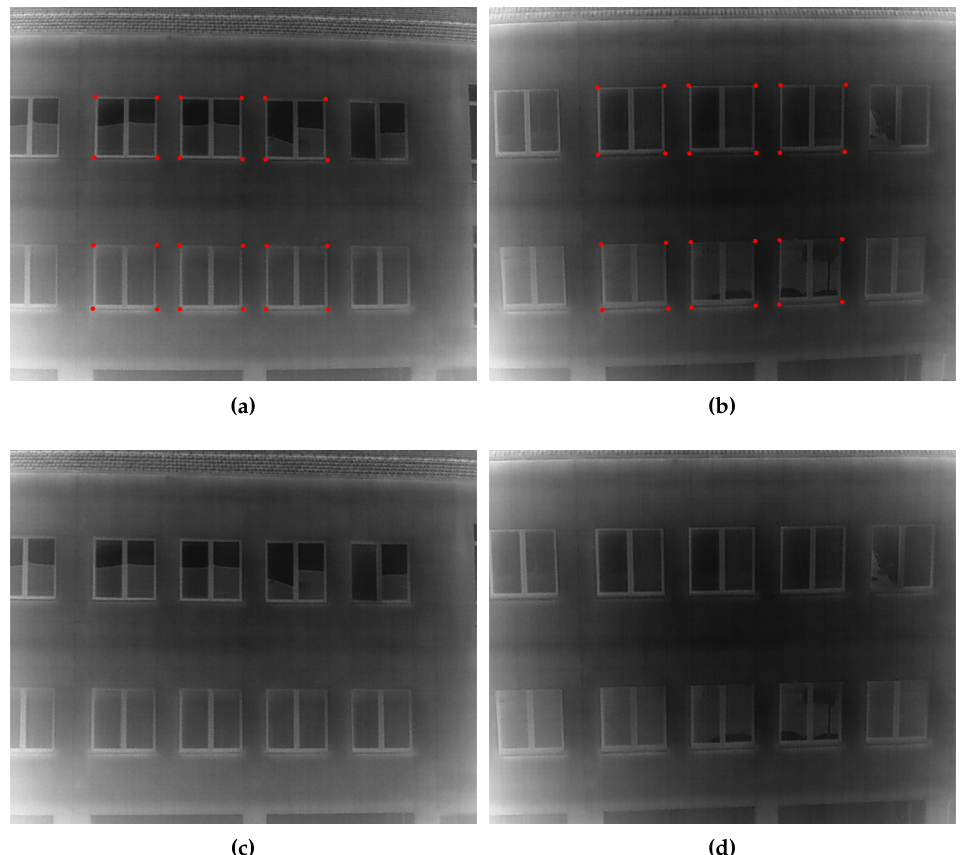
Figure 3. Image undistortion for infrared images. ( a ) Natural landmarks on orientation 1, ( b ) Natural landmarks on orientation 2. ( c ) Image undistorted after calibration for orientation 1. ( d ) Image undistorted after calibration for orientation 2.